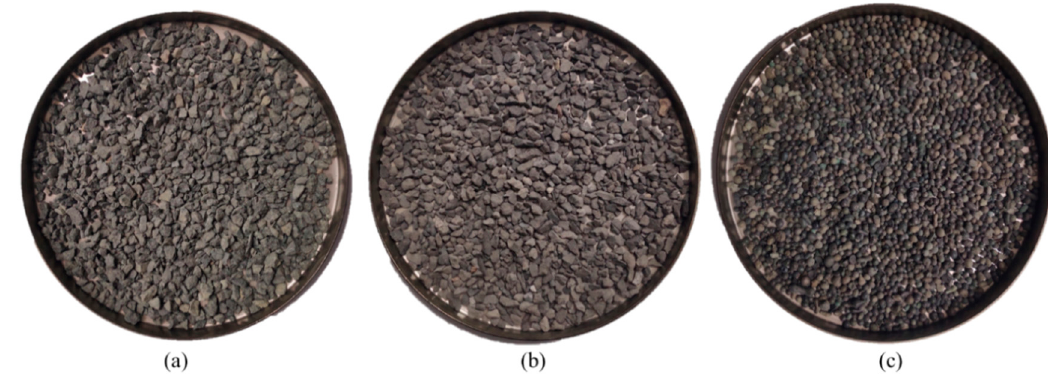
Figure 2. Aggregate sample: ( a ) BS, ( b ) basic oxygen furnace (BOF) slag, ( c ) FER slag.